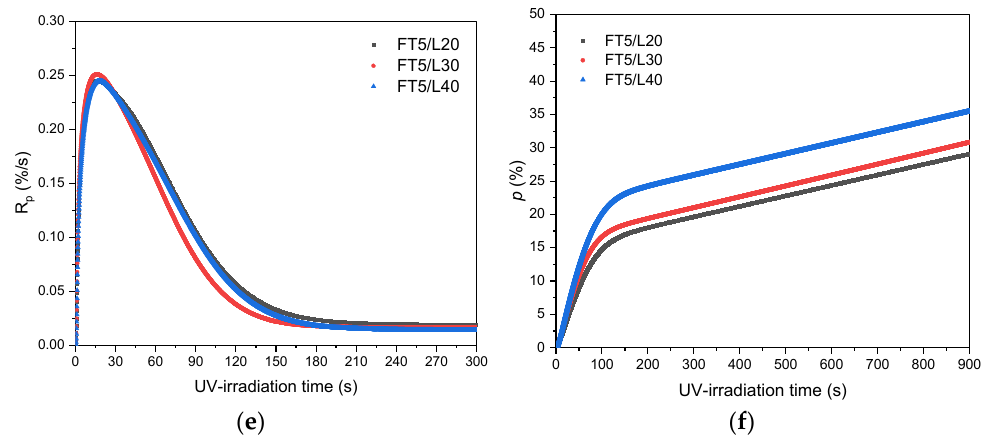
Figure 3. Reaction rate (R p ) and conversion of double bonds ( p ) for the UV-phototelomerization process of BA, BMA, and LMA in the presence of different fluorotelogen doses ( a , b ), with 2.5 wt. parts of the fluorotelogen and different LMA content ( c , d ), or with 5 wt. parts of the fluorotelogen and different LMA content ( e , f ) (I 0 = 15 mW/cm 2 ; 320–390 nm; Ar).